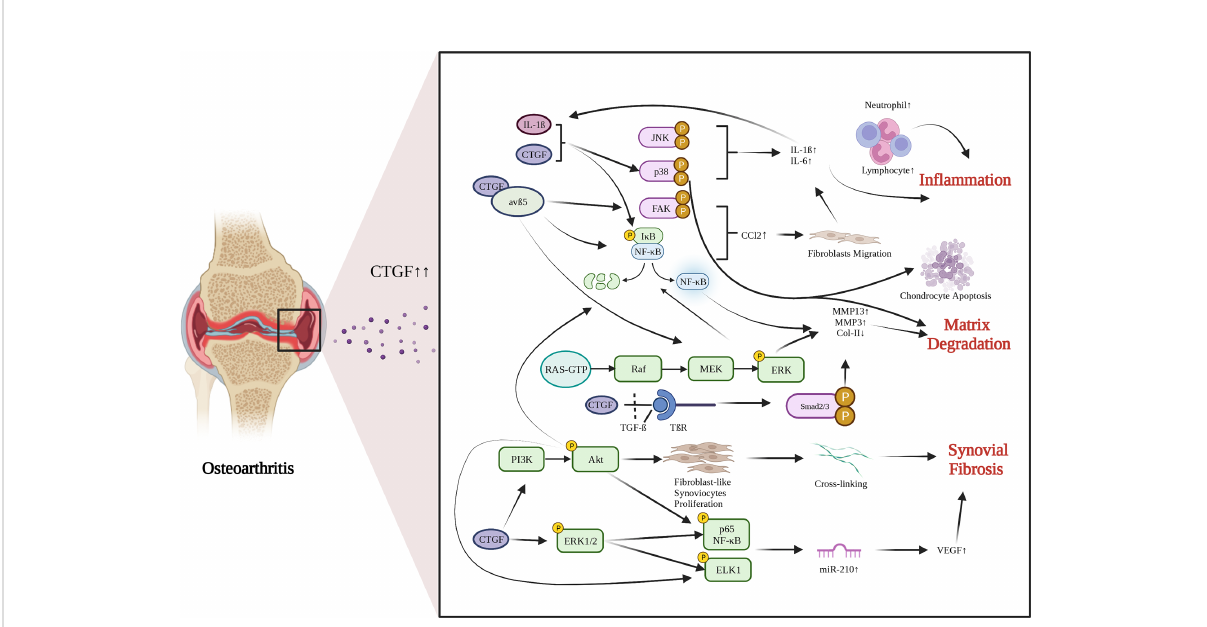
FIGURE 1 Functions and pathways of CTGF in OA development. CTGF is involved in promoting in fl ammation, matrix degradation and synovial fi brosis in articular joints. Created with